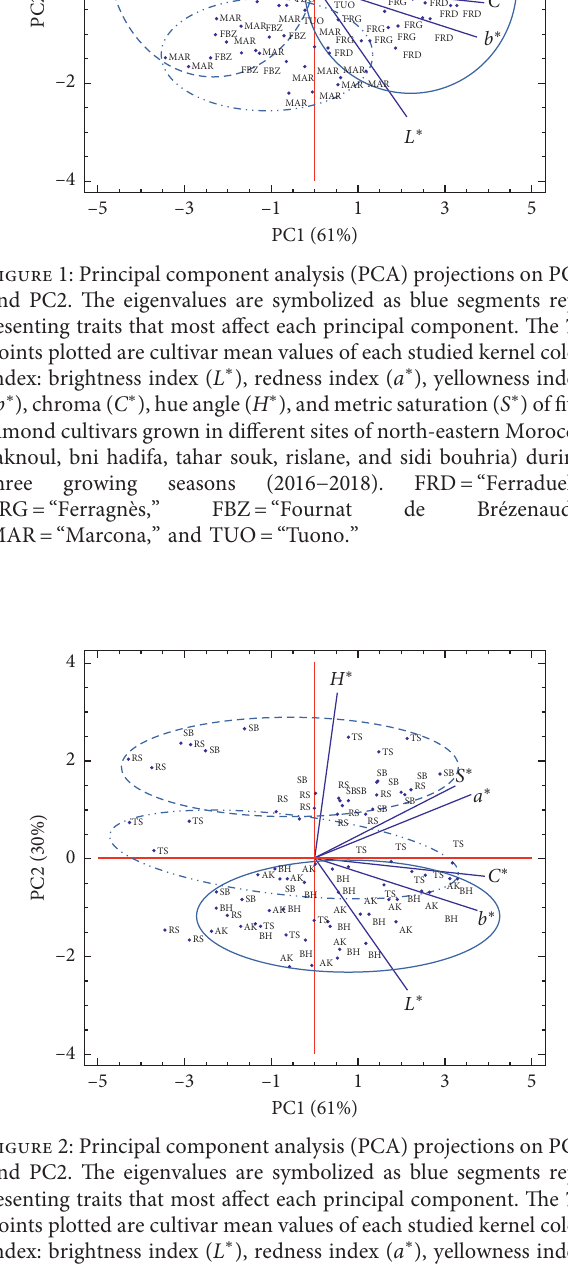
Table 3: Coefficients of correlation among the studied traits: brightness index ( L ∗ ), redness index ( a ∗ ), yellowness index ( b ∗ ), chroma ( C ∗ ), hue angle ( H ∗ ), and metric saturation ( S ∗ ) of five almond cultivars grown in different sites of northern Morocco (Aknoul, Bni Hadifa, Tahar Souk, Rislane, and Sidi Bouhria) during three growing seasons (2016 − 2018). ∗ , ∗∗ , and ∗∗∗ indicate sig- nificance at 0.05, 0.01, and 0.001 levels of probability,